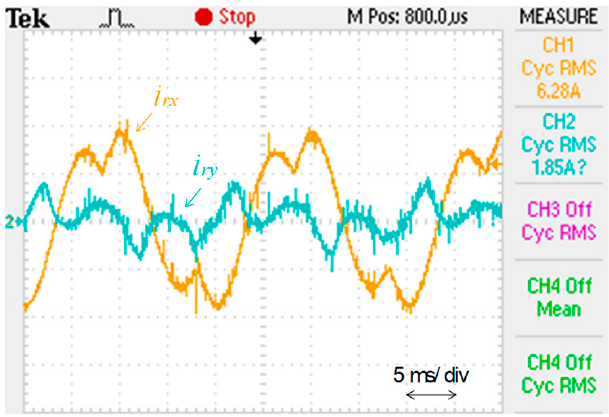
Figure 23. Experimental results (when two load sections are loaded): phase x compensation current ( i rx : 5 A/div); phase y compensation current ( i ry : 5 A/div).